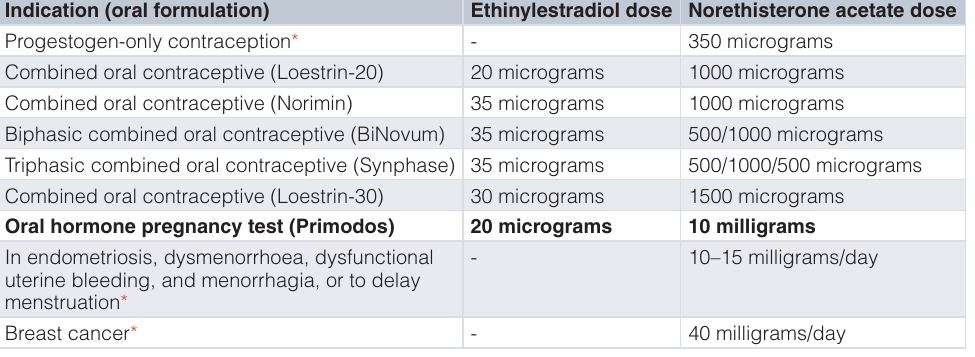
Table 1. Doses of ethinylestradiol and norethisterone in various formulations of contraceptive steroids, ordered by increasing dose of norethisterone. Indication (oral